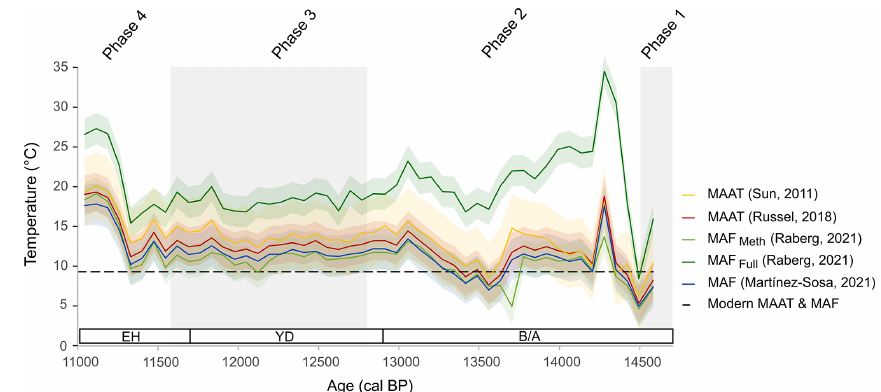
Figure 8. Mean annual air temperature (MAAT) based on global (Sun et al., 2011) and East African (Russell et al., 2018) lacustrine calibrations and mean temperature of months above freezing (MAF) based on Bayesian statistics (Martínez-Sosa et al., 2021) and global (Raberg et al., 2021) lacustrine calibrations against age for the Matese core. Shaded areas correspond to the error associated with calibrations and dashed lines correspond to modern climate values of Lake Matese. B/A stands for Bølling–Allerød. YD stands for Younger Dryas. EH stands for early